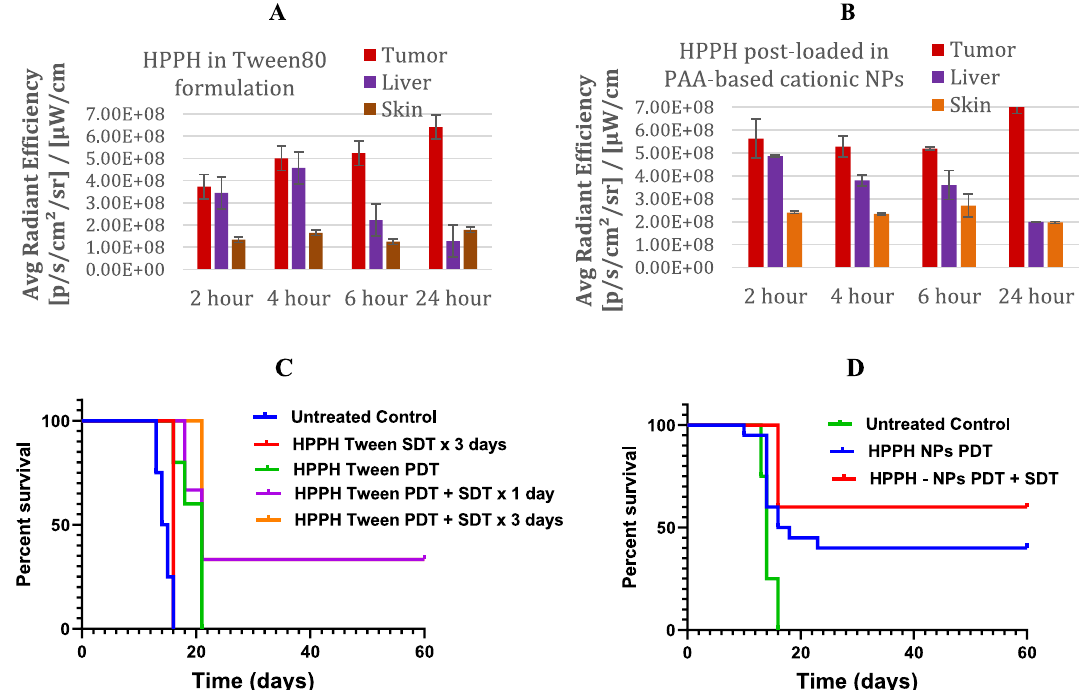
Figure 8. Comparative tumor uptake of HPPH in ( A ) Tween80 formulation, and ( B ) HPPH post-loaded in PAA cationic NPs at 2, 4, 6 and 24 h post-injection (HPPH in Tween or PNPs formulation at a dose of 0.47 μmol/kg). Antitumor activity of PDT and PDT + SDT combination of HPPH (0.47 μmol/kg) formulated either ( C ) in Tween80 or ( D ) post-loaded in PAA cationic NPs in SCID mice bearing U87 glioma xenografts: Compared to HPPH Tween-80 formulations at a dose of 0.47 μmol/kg, the HPPH post-loaded in cationic PAA- NMe 3 + at the same dose showed significantly enhanced long-term tumor cure with no mortality. Light dose: 665 nm, 135 J/cm 2 , 75 MW/cm 2 ) at 24 h post ‐ injection of PS), US dose: 0.5 W/cm 2 , 3.3 MHz, 30 min. HPPH- PAA NPs in combination of PDT & SDT gave 60% tumor cure (6/10 SCID mice were tumor free on day 60, p -value 0.04.